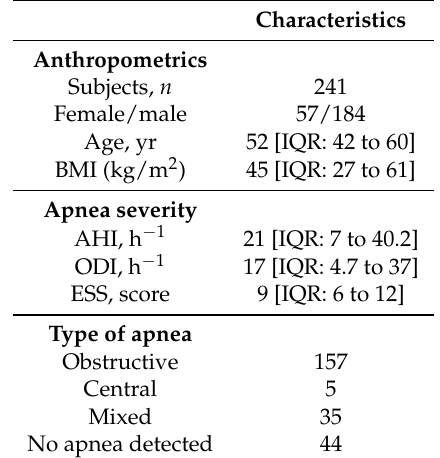
Table 1. Patient characteristics. Results are reported as median [inter-quartile range (IQR)], unless otherwise